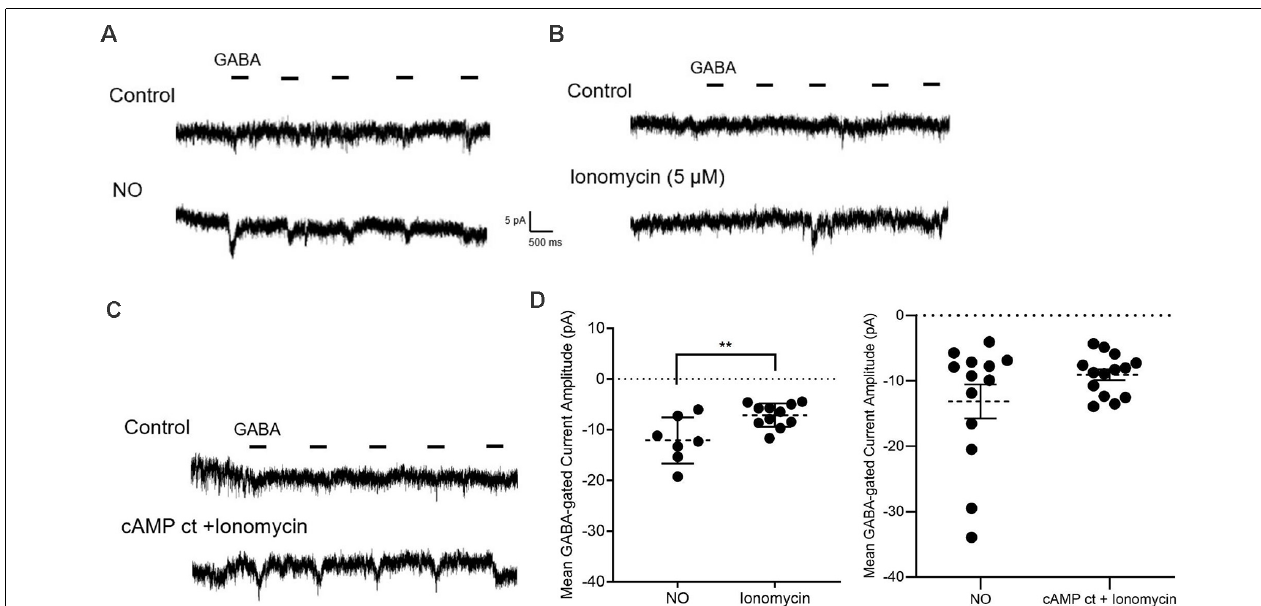
FIGURE 8 | Pairing elevated cAMP and Ca 2+ mimics the effects of NO. (A–C) Sample traces from GABA pulse recording (20 µ M) in zero external Ca 2+ and zero Cl − internal and external solutions. The GABA-dependent inward current is elicited by NO (50 µ l) in (A) by Ca 2+ ionophore, ionomycin (5 µ M) in ( B) , and by co-application of cAMP ct and ionomycin (5 µ M) in (C). (D) The quantified mean GABA-gated current amplitude ± SEM; NO, n = 7; ionomycin, n = 11. NO, n = 13 (control cells are replotted from Figure 5D , see “ Materials and Methods” section); cAMP ct and ionomycin, n = 14. ** P < 0.01 (left: unpaired t -test, right: Welch’s unpaired t